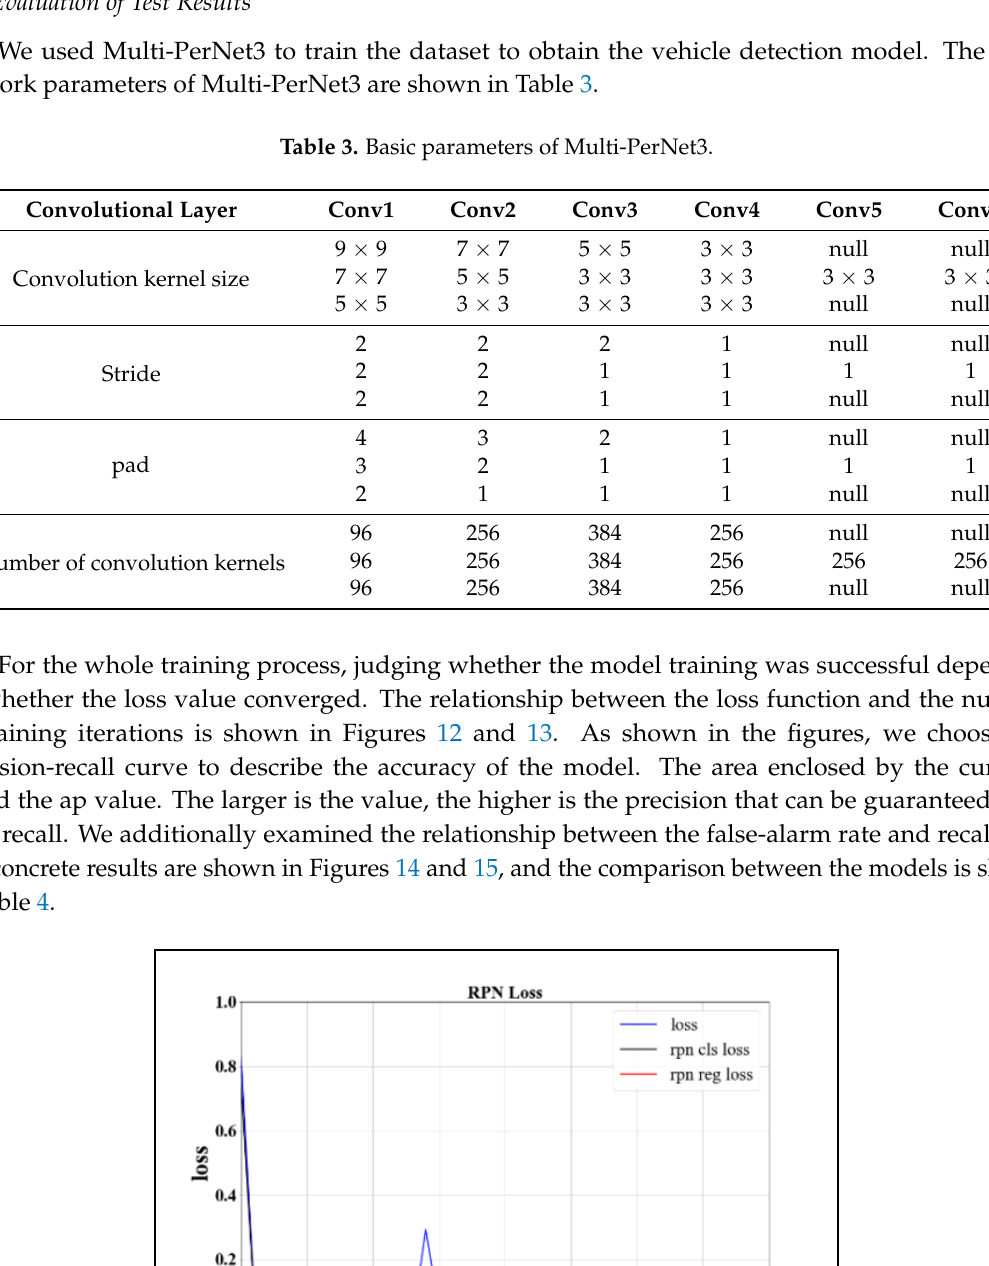
Figure 13. Loss curve of detector training process. Figure 14. P-R curve.